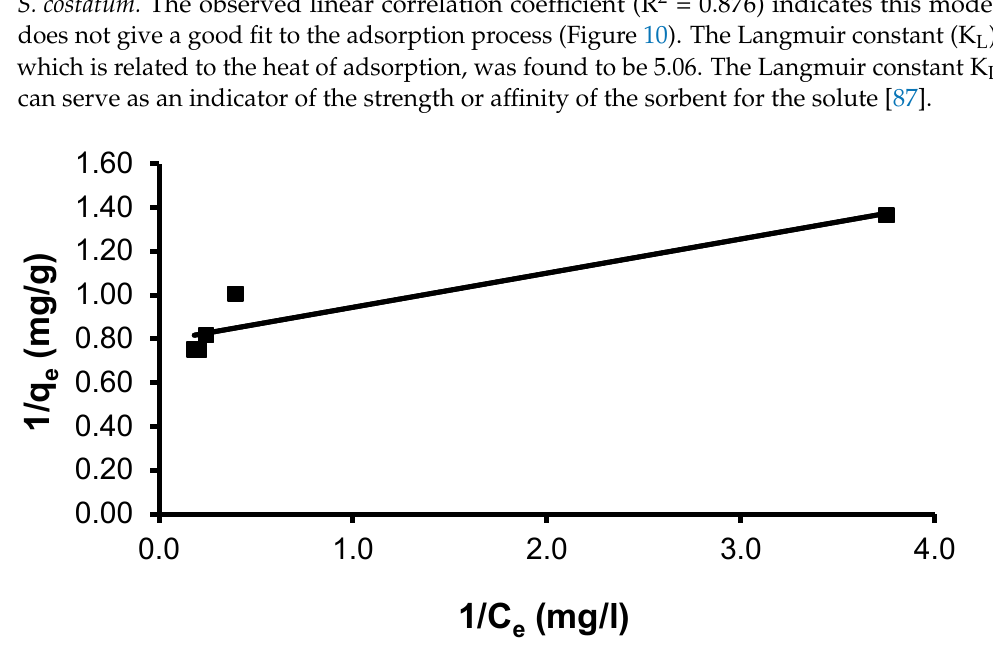
Figure 10. Plot of the Langmuir isotherm model for CVD adsorbed onto S. costatum .